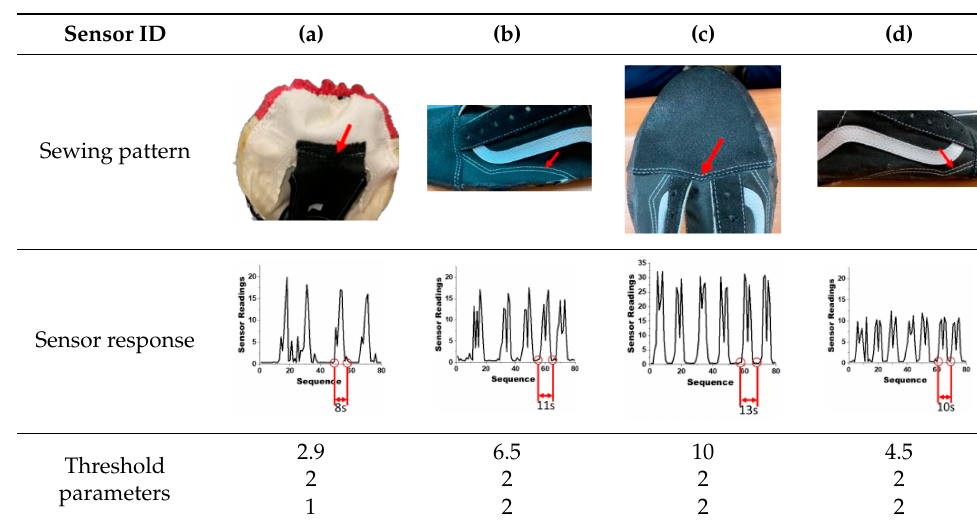
Figure 5. The installation of the sensors on the selected machines of sewing and cutting production lines. ( a – e ) are the sewing machines with the sensor installation locations (with red arrow), and ( f , g ) are the cutting machines. Table 1. The machine utilization conversion from the sensor data by the threshold